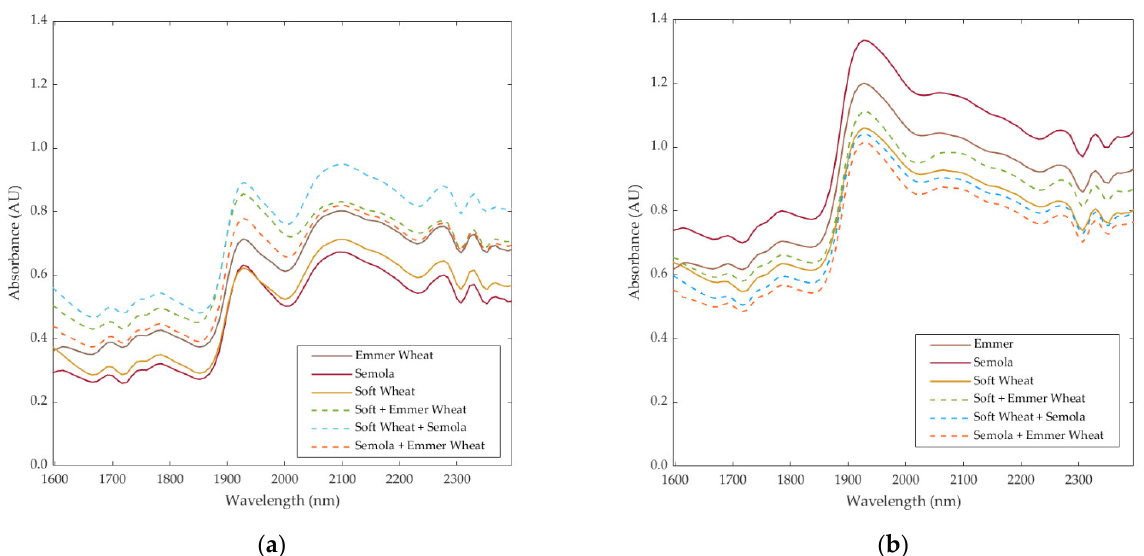
Figure 4. Near-infrared spectroscopy curves within the 1596–2395 nm range for the sourdough bread ( a ) crust and the crumb ( b ). ( a ) crust and the crumb ( b